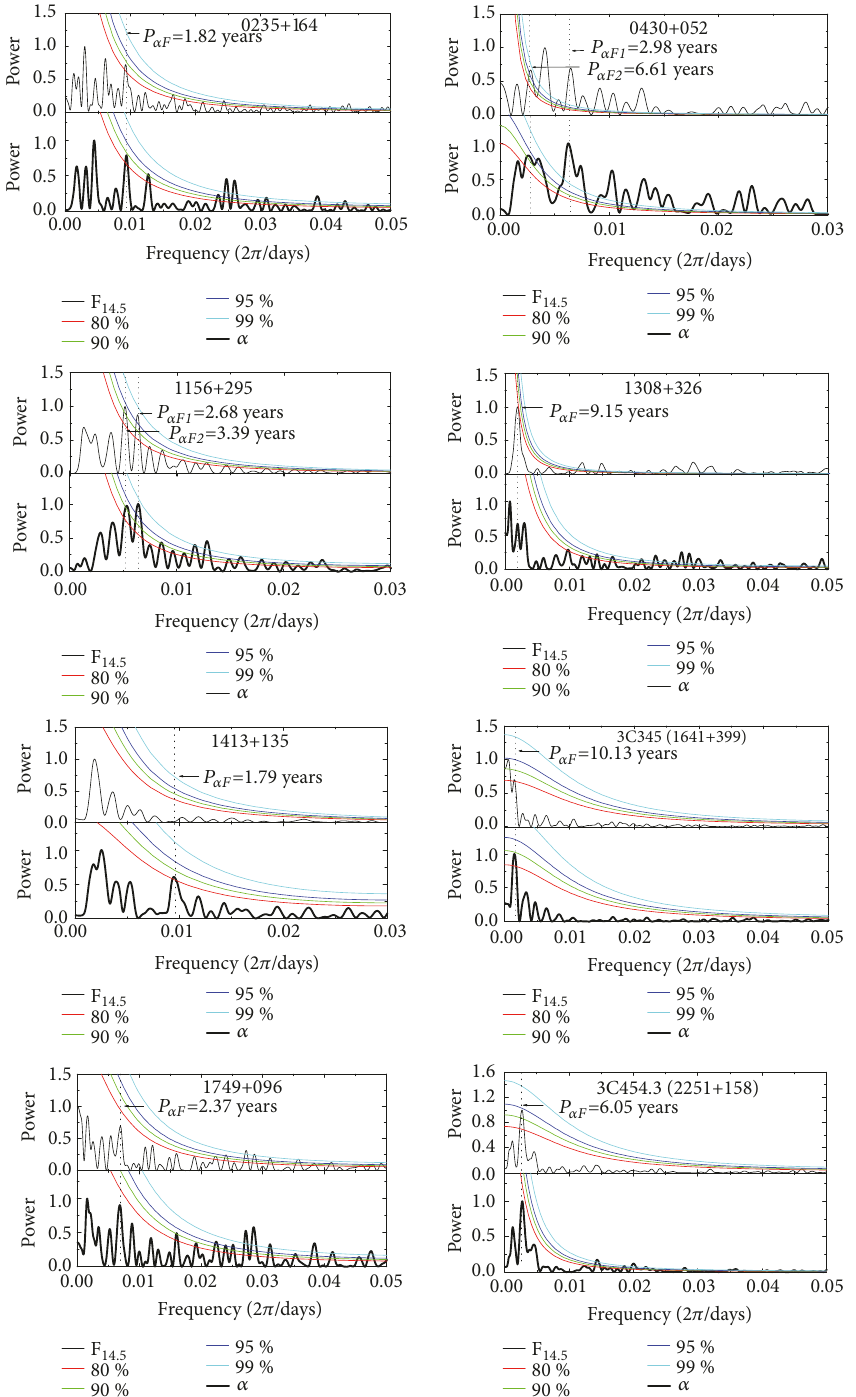
Figure 5: The quasi-periodicities of 8 targeted sources. The upper panels are derived from the light curves and the lower panels are from spectral indices. The black lines indicate periodic signals. The red, green, blue, and cyan lines show 80%, 90%, 95%, and 99% red noise level,